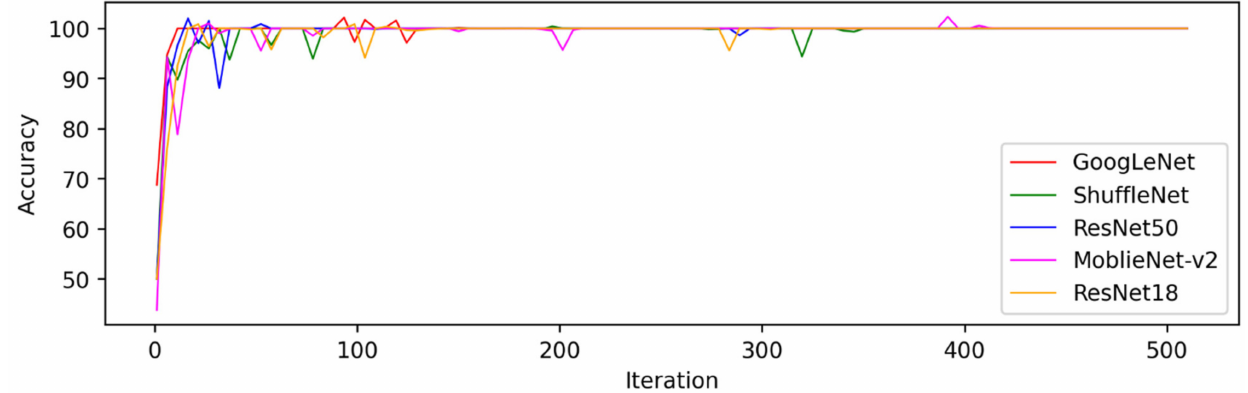
Figure 12. Comparison of training accuracy of recognition classification